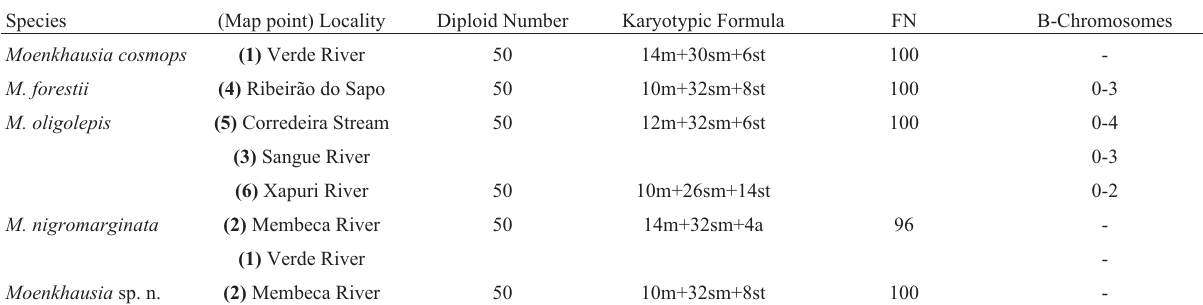
Table 2 - Cytogenetic data found in the species or populations of Moenkhausia analyzed in this study.